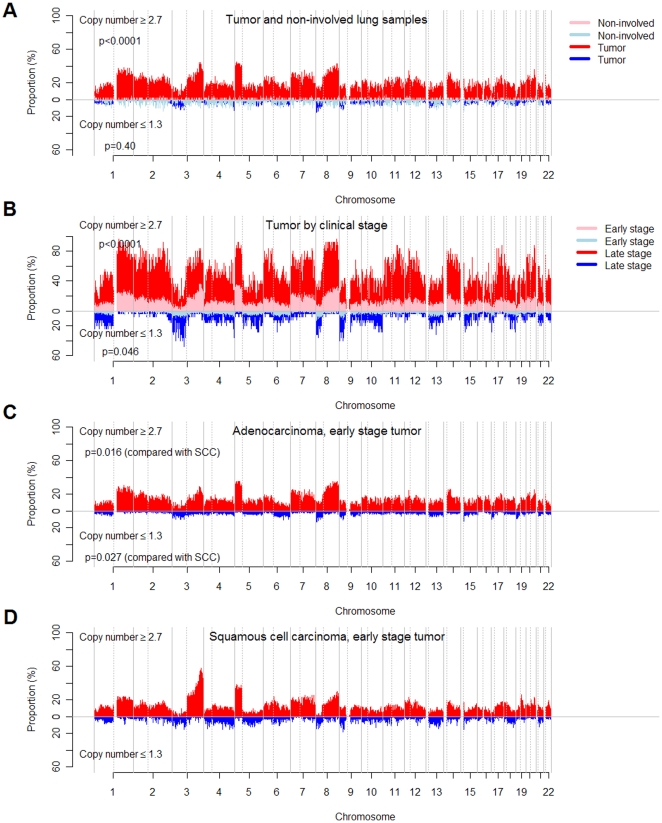
Genome-wide copy number alterations in blood, non-involved lung tissue and tumor of NSCLC patients.The x axis represents genomic locations, which were ordered by the somatic chromosomes. The y axis represents the prevalence (%) of NSCLC patients having copy number ≥2.7 (red or pink) and ≤1.3 (blue or light blue) in non-involved lung tissue and total tumor (A), early stage tumor and late stage tumor (B), early stage tumor of adenocarcinoma (C) and early stage tumor of squamous cell carcinoma (SCC) (D). The corresponding plots of −log10(q values) were shown in Fig. S1. The p values of comparing genome-wide CNAs patterns between non-involved tissue samples and total tumors are <0.0001 for gains and 0.40 for losses by the permutation-based global test with details described in Methods. The p values comparing early stage and late stage tumors are <0.0001 for gains and 0.046 for losses; the p values comparing early stage adenocarcinoma (C) and early stage squamous cell carcinoma (D) are 0.016 for gains and 0.027 for losses.